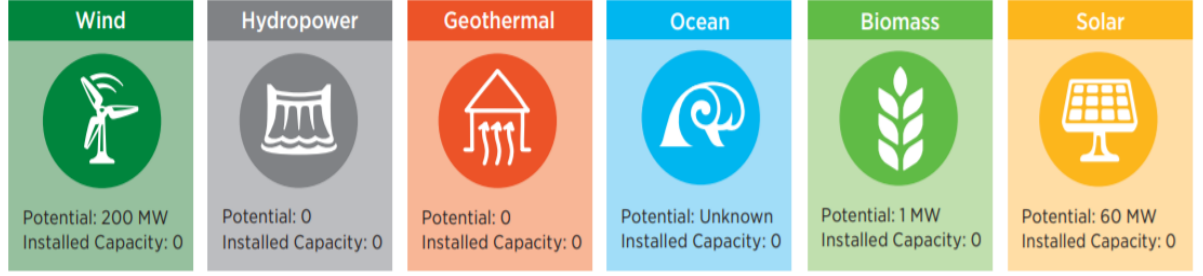
Figure 1. Renewable energy status and potential (adapted from NREL, 2015 [66]).